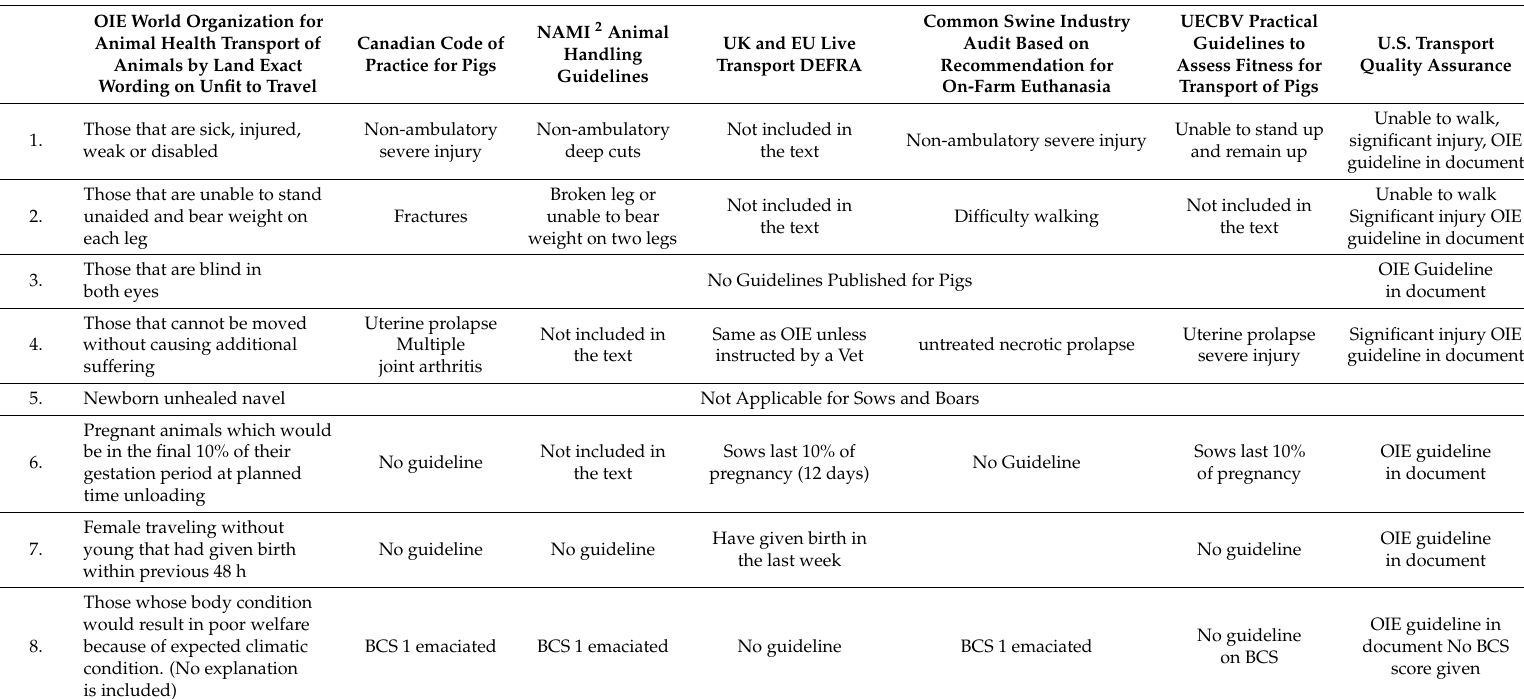
Table 1. Comparison of OIE (World Organization for Animal Health) requirements on unfit to travel with other regulations and industry guidelines that would apply to sows and boars 1